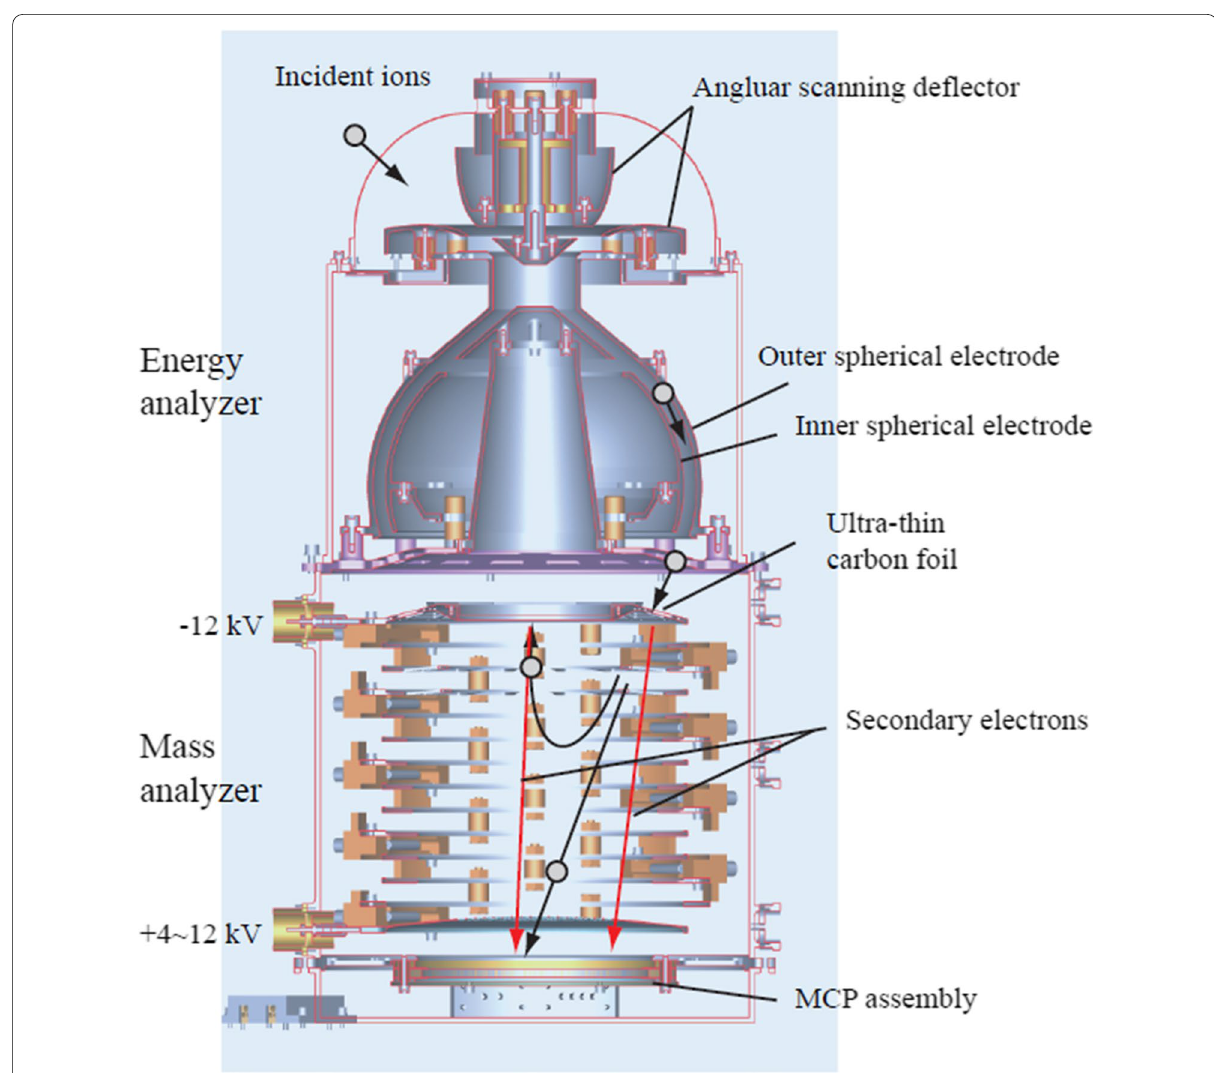
Fig. 3 Cross-sectional view of the ion optics and MCP assembly in the MSA ion energy mass spectrometer engineering model. Trajectories of incident ions (black) and secondary electrons (red) are